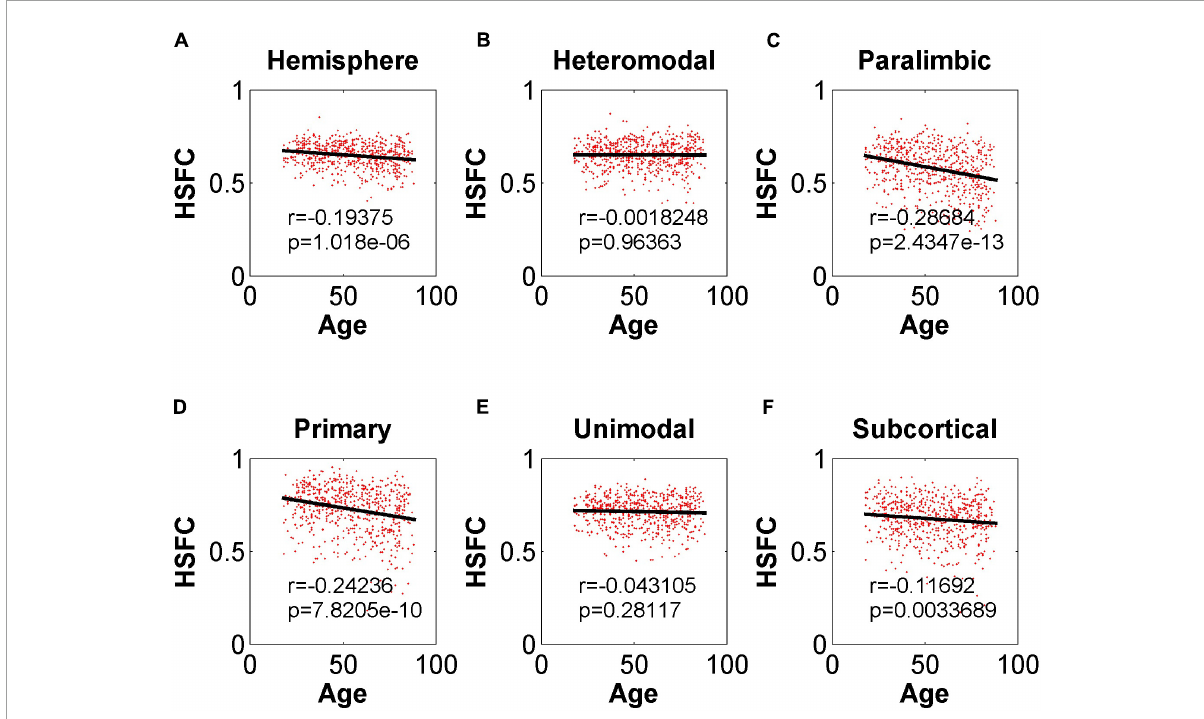
FIGURE9 Pearson correlation between age and HSFC of hemisphere and five sub-modules for BNA template with GSR. (A–F) Represent the hemisphere, heteromodal, paralimbic, primary, unimodal, subcortical, respectively.